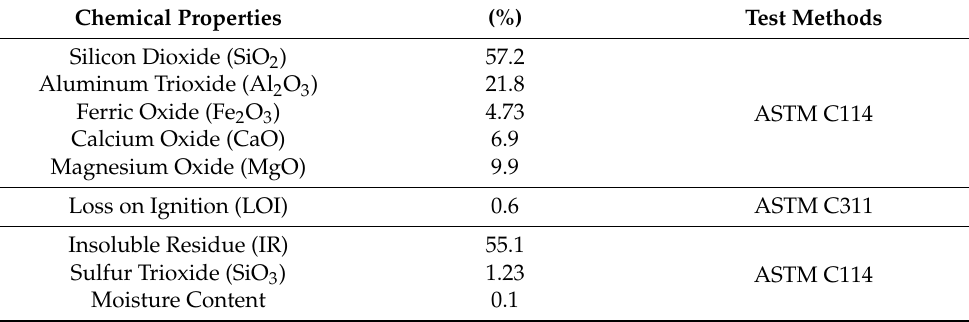
Table 2. Chemical composition of fly ash (provided by manufacturer).